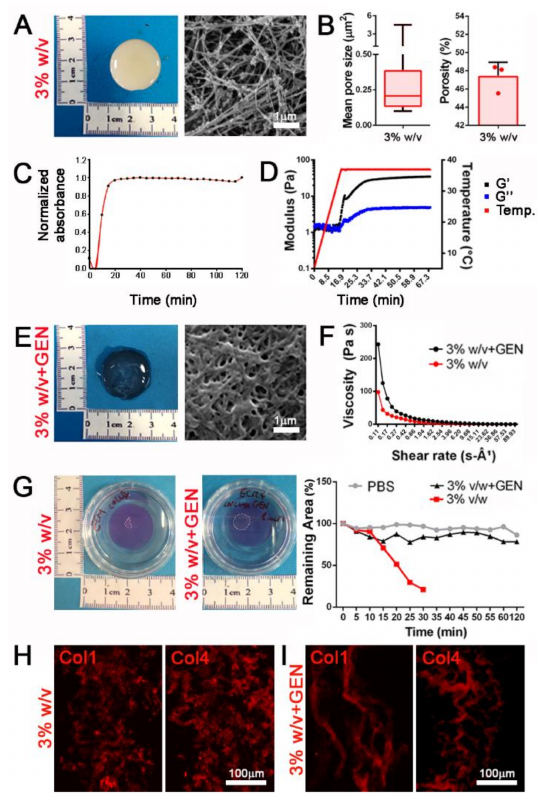
Figure 3. dECM-derived hydrogels can be chemically modified to increase the mechanical properties. ( A ) Gross appearance and ultrastructure of 3% w/v hydrogels. ( B ) Mean pore size and porosity of 3% w/v hydrogels. ( C ) Turbidimetric gelation kinetics of 3% v/w dECM-derived hydrogel, reported in terms of normalized absorbance vs. time. ( D ) Storage (G (cid:48) ) and loss (G”) moduli of 3% w/v dECM-derived hydrogel obtained from rheological analysis increasing temperature (from 0 to 40 ◦ C) during time (from 0 to 60 min). ( E ) Gross appearance and ultrastructure of 3% w/v hydrogels after crosslinking with genipin (+GEN). ( F ) Viscosity properties under different shear rate of 3% w/v hydrogels with and without genipin crosslinking. ( G ) Degradation assay of 3% w/v hydrogels with and without genipin crosslinking using collagenase II. PBS: 3% w/v hydrogels without genipin and incubated with PBS (no collagenase II). ( H , I ) Immunofluorescence staining for the detection of Col1 and Col4 in 3% w/v hydrogels and cross-linked hydrogels with 1 mM genipin (3% w/v +